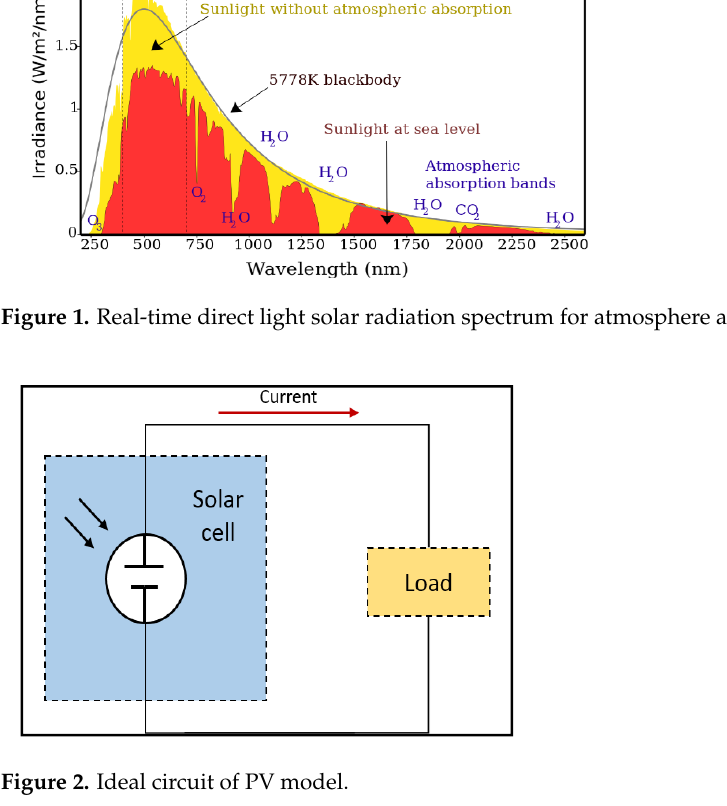
Figure 2. Ideal circuit of PV model.